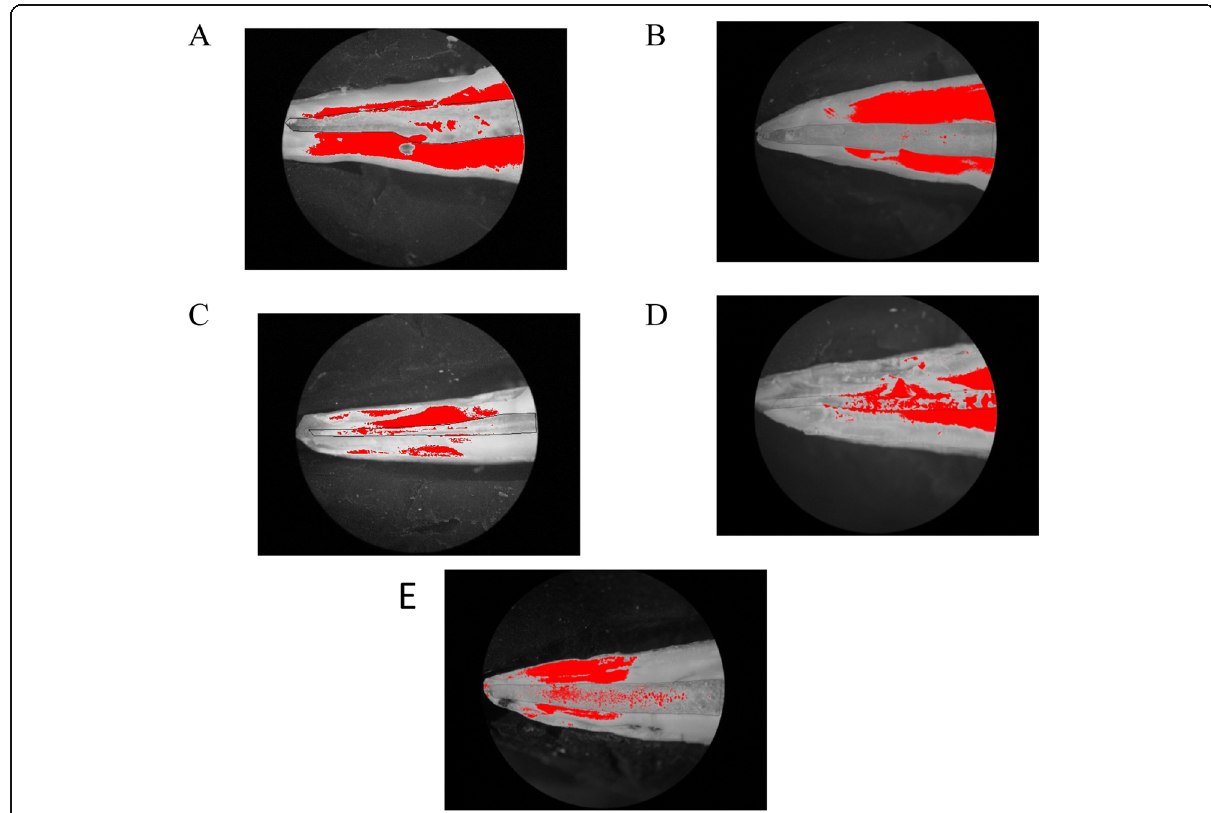
Fig. 3 Image analysis of stereomicroscope images (× 25) showing remaining debris (red) in the apical third of the different groups: a group 1,